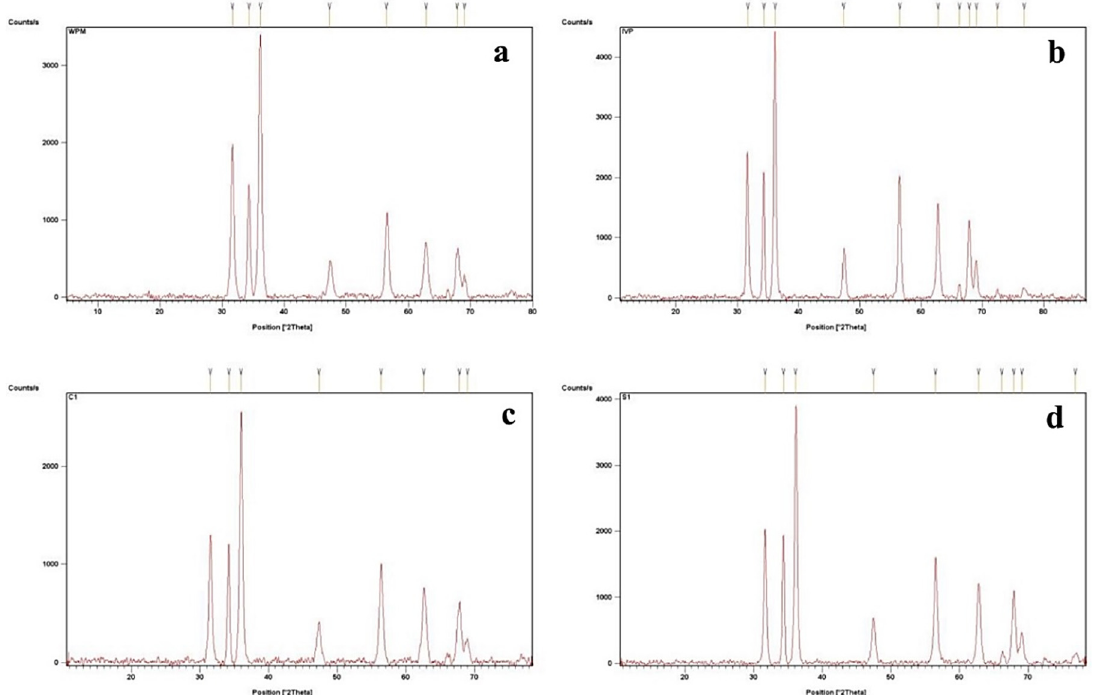
Figure 1. X-ray diffraction analysis of ( a ) wild plant extract mediated ZnO nanoparticles (NPs) (W-ZNPs), ( b ) in vitro derived plantlets extract mediated ZnO NPs (P-ZNPs), ( c ) callus extract mediated ZnO NPs (C-ZNPs) and ( d ) seed extract mediated ZnO NPs (S-ZNPs).